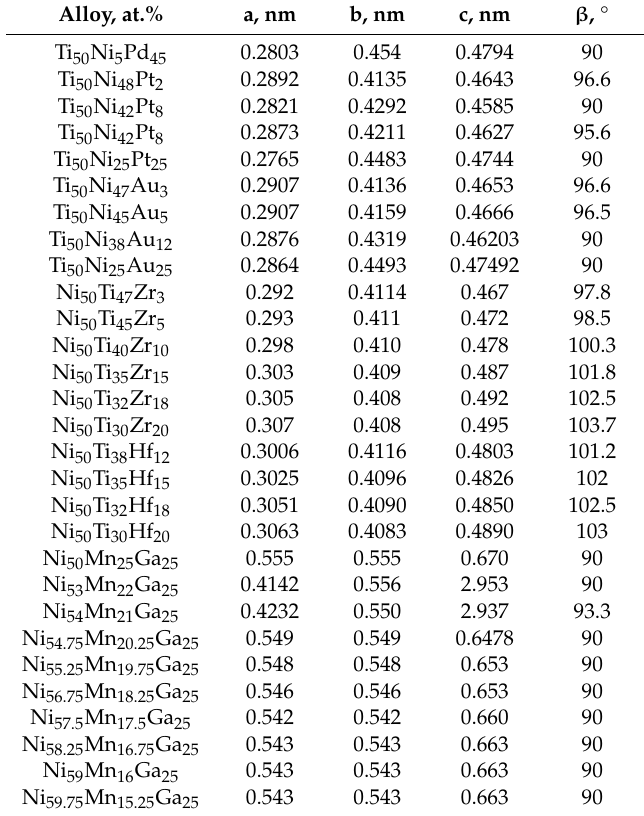
Table 7. The martensite lattice parameters of ternary TiNi- and Ni 2 MnGa-based alloys. Alloy, at.% a, nm b,